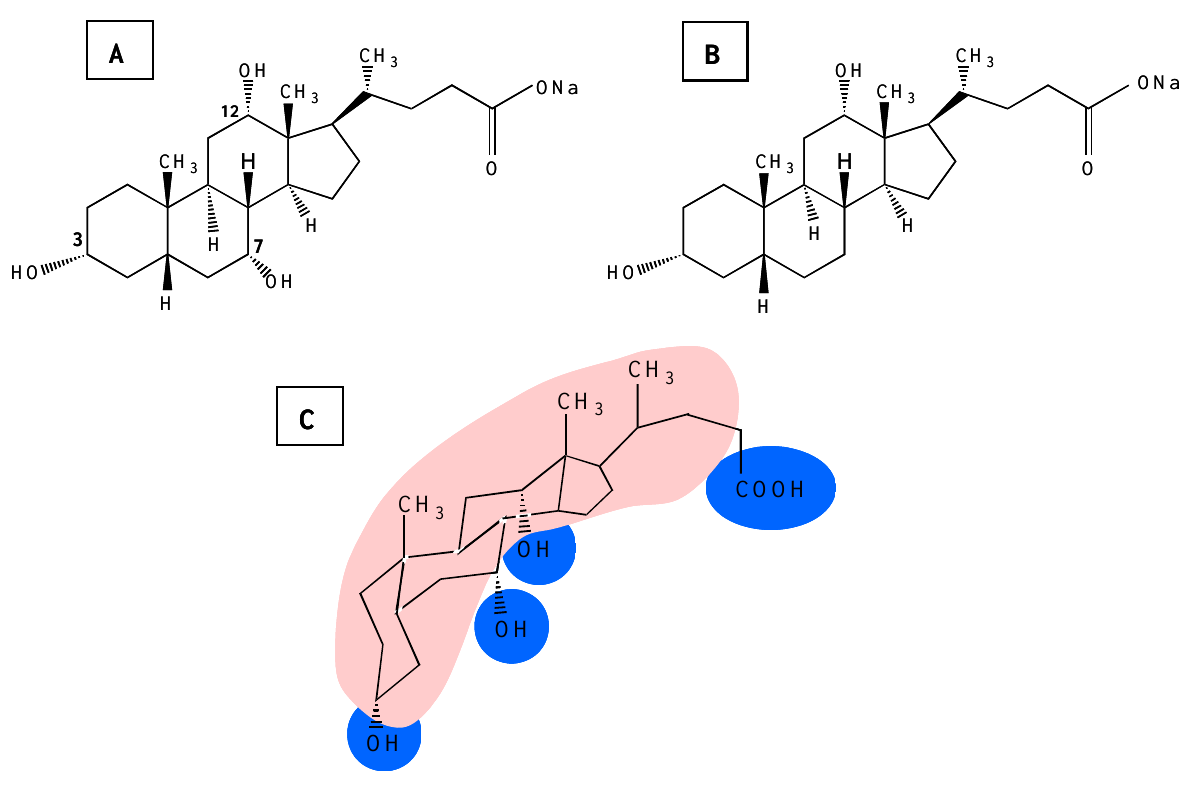
Figure 1. Chemical structure of the two bile salts: ( A ) sodium cholate (NaC) and ( B ) sodium deoxycholate (NaDC). Under physiological conditions (300 mOsmol, pH 7) bile salts are negatively charged. ( C ) Structural formula of sodium cholate showing the hydrophobic surface (indicated in red) and the hydrophilic parts (indicated in blue) of the